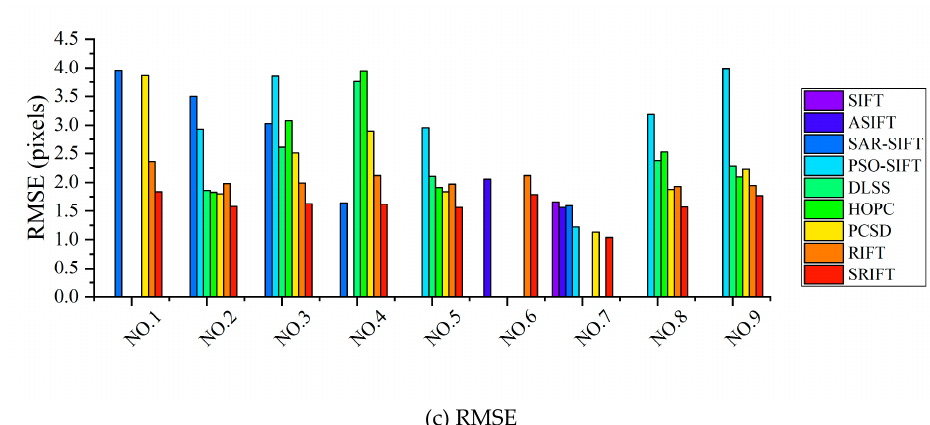
Figure 11. Performance comparison of the different descriptors on the input images.